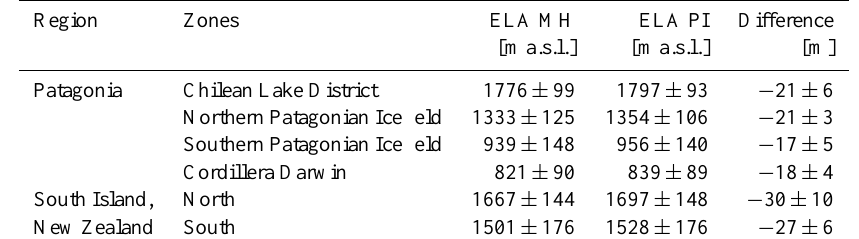
Table 2. Mean values of ELA for each zone.